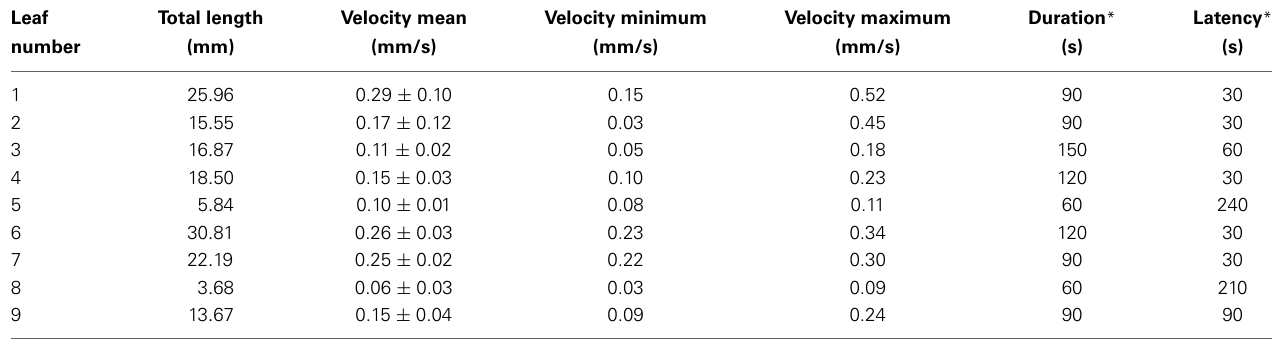
Table 1 | Ca 2 + wave properties in different leaves of an intact plant.